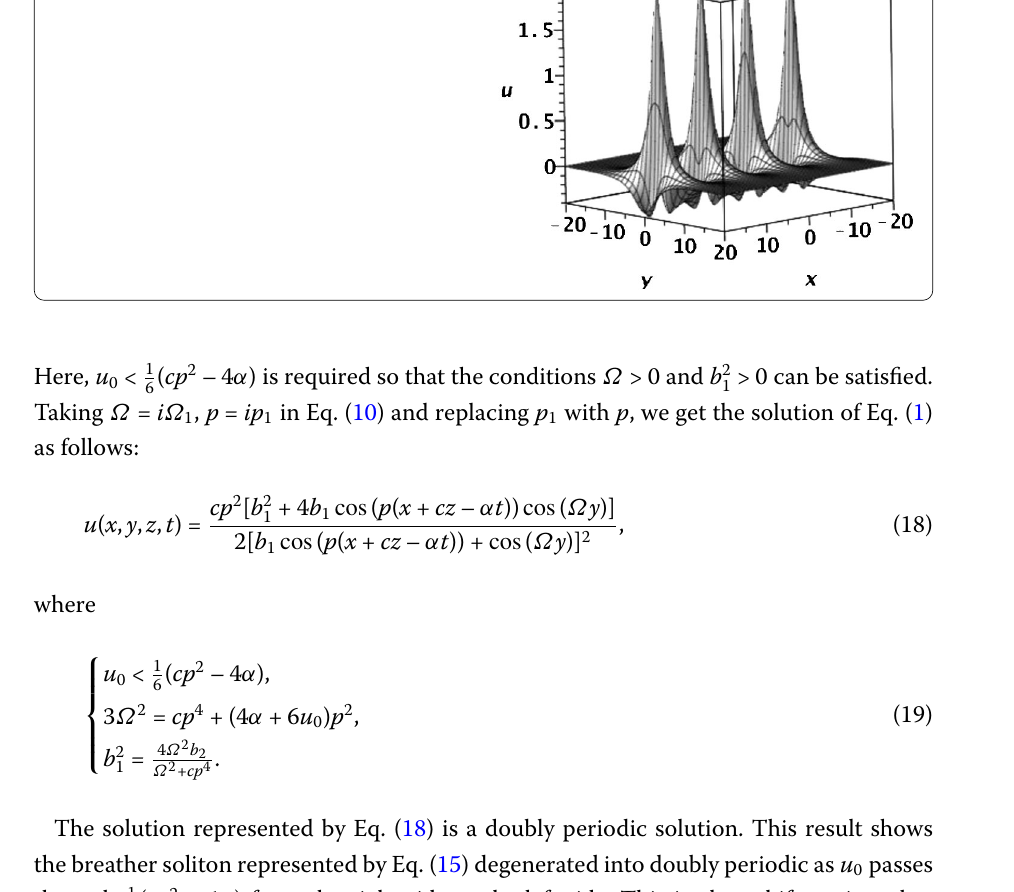
Figure 3 The periodic solitary solution (15) with